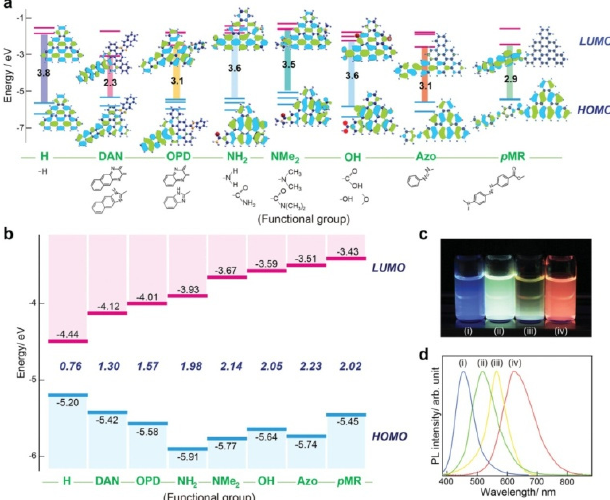
Figure 3. Energy levels and photoluminescence for nitrogen-functionalized graphene quantum dots (NGQDs). ( a ) Predicted energy level diagrams for graphene with different functional groups: ab initio calculations were performed at the B3LYP/6-31+G (p,d) level of theory using the Gaussian 09 package. Schematic illustrations show the chemical structures used for theoretical calculations. The isosurface presents the highest occupied molecular orbital (HOMO) and the lowest unoccupied molecular orbital (LUMO). ( b ) Measured energy level diagram for NGQDs. It is noteworthy that the mismatch between the predicted energy levels and the measured ones arises from the difference in the size of NGQDs and the quantity of nitrogenous functional groups. ( c ) Photoluminescence (PL) image of NGQDs in aqueous solution excited using a UV lamp (365 nm): (i) GQDS functionalized with azo (Azo-GQDs); (ii) NH2-GQDs; (iii) GQDS functionalized with o-phenylenediamine (OPD-GQDs); and (iv) GQDS functionalized with diaminonaphthalene (DAN-GQDs). ( d ) Corresponding normalized PL spectra (excited at 380 nm) from aqueous dispersions of NGQDs. Reprinted with the permission of Reference [72]. Copyright 2011 The Royal Society of Chemistry.